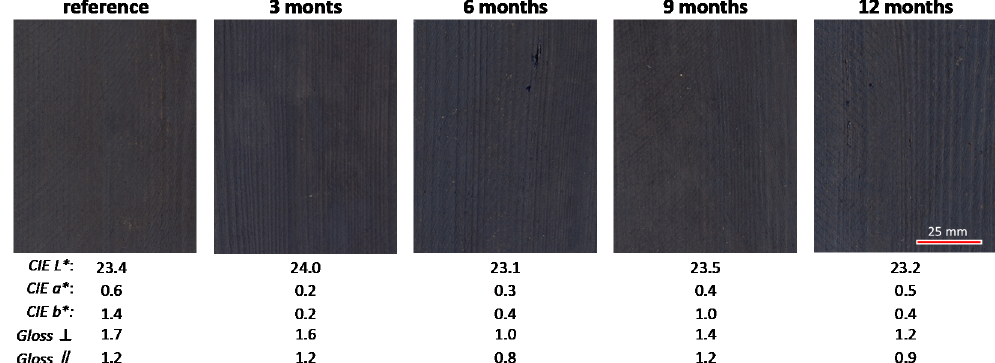
Figure 2. Surface texture, CIE L * a * b * colour coordinates and glossiness parameters altered during weathering progress of biofinish-coated Scots pine samples.